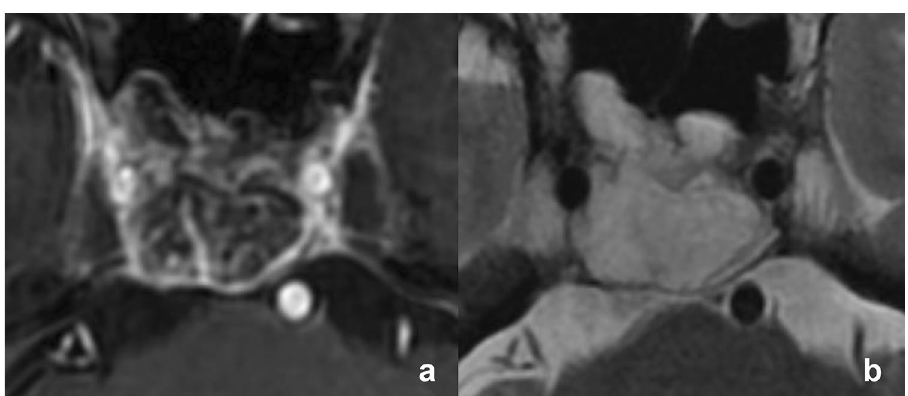
Figure 2. Magnetic resonance imaging of stroma-poor chordoma. ( a ) Contrast-enhanced T1-weighted and ( b ) T2-weighted imaging show a poorly enhancing mass originating from the clivus with T2 high signal